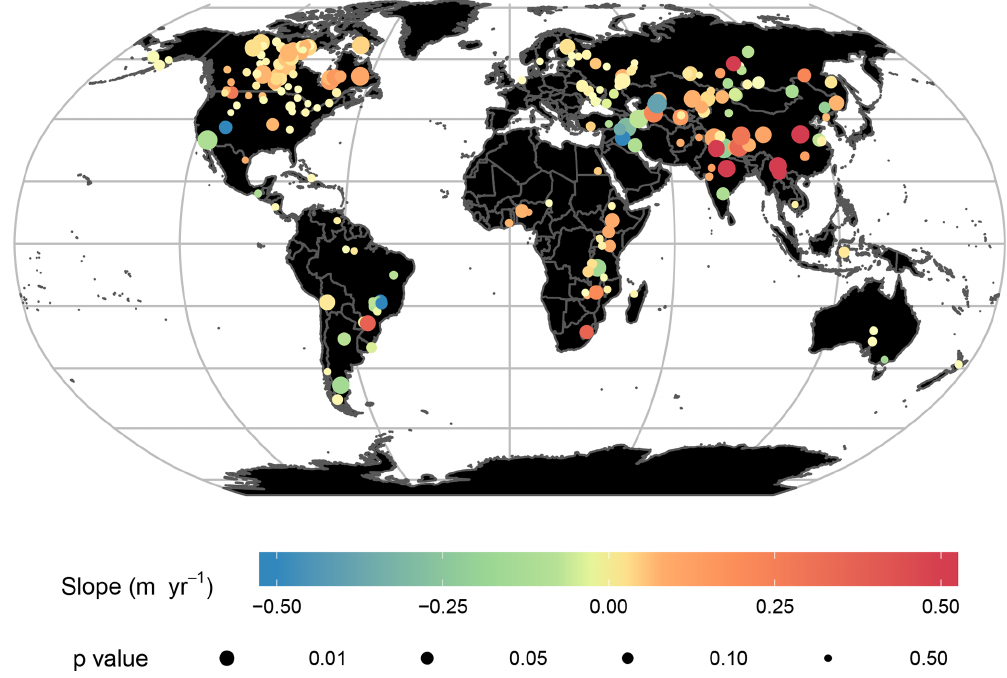
Figure 2. Long-term trends in water levels prior to removing the effects of background climate variation. Some lakes – including those in the southwest United States, parts of Africa, and the Middle East – show regionally consistent patterns in water